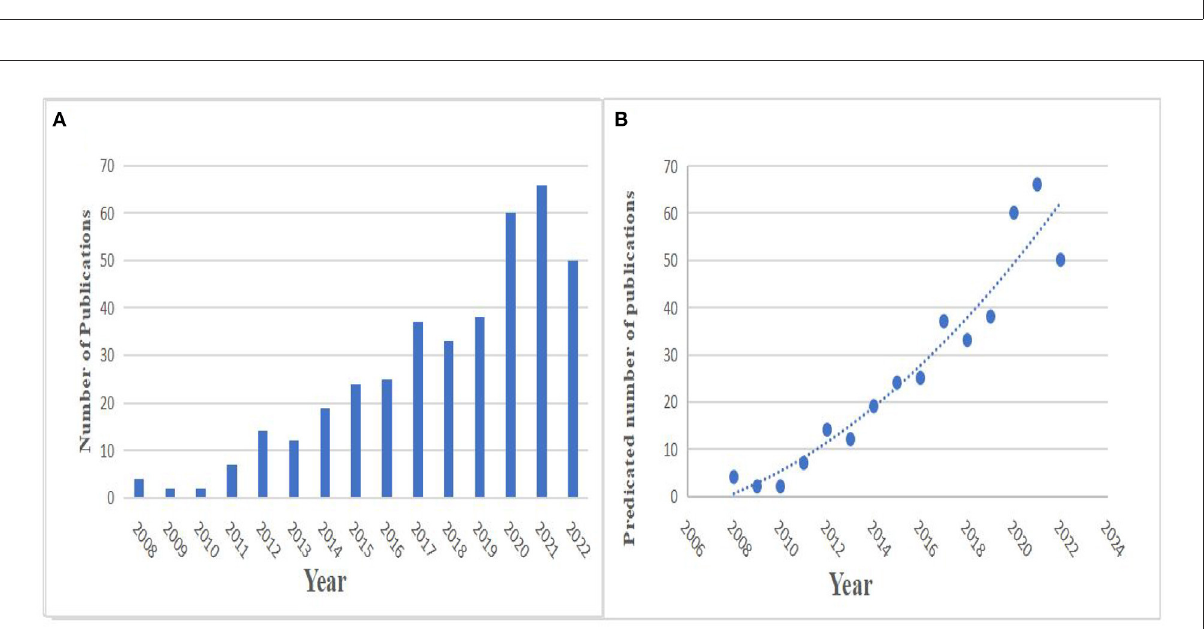
FIGURE2 Global trends in publications on acupuncture for cognitive impairment. (A) Number of publications over the past 15 years. (B) Display publication growth trends and curves, and forecasts for future